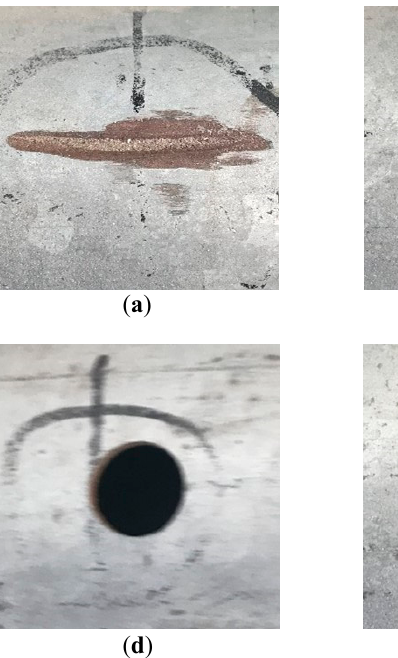
× 1 mm; ( b ) The size of axial crack is 1 mm × 20 mm × 1 mm; ( c ) The size of axial crack is 12 mm × 20 mm ×